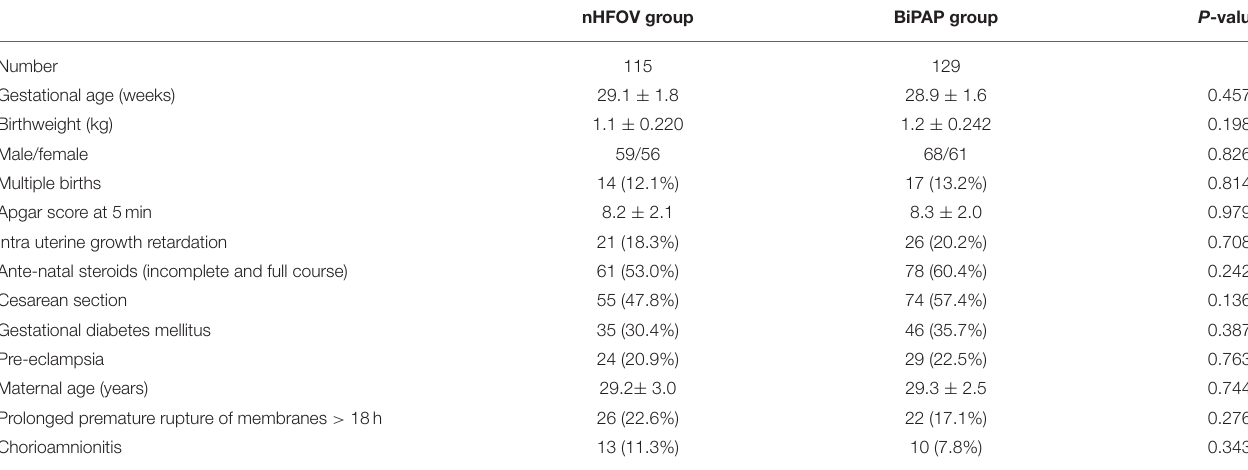
TABLE 1 | Comparison of general data between the two